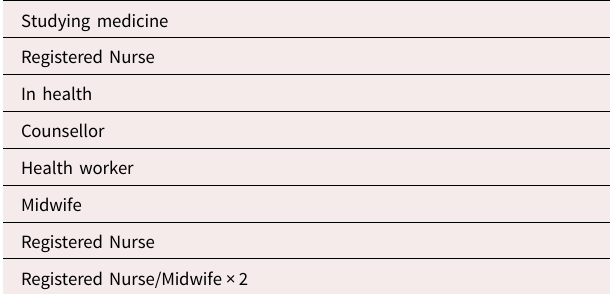
Table 1. Knowledge and skills for Practitioner practice Clinical skills for competent practice